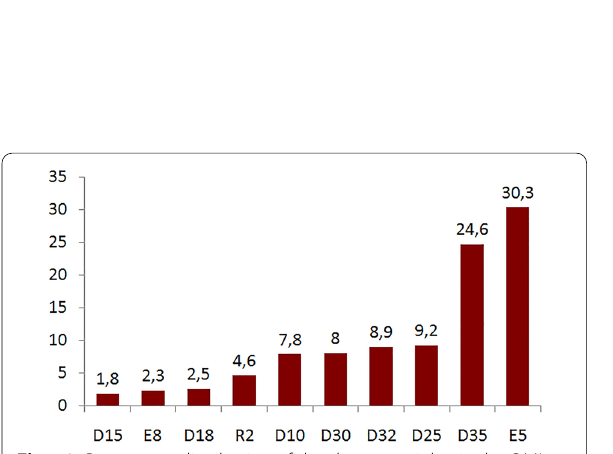
Fig. 10 Percentage distribution of development rights in the OMI zones of the sending area